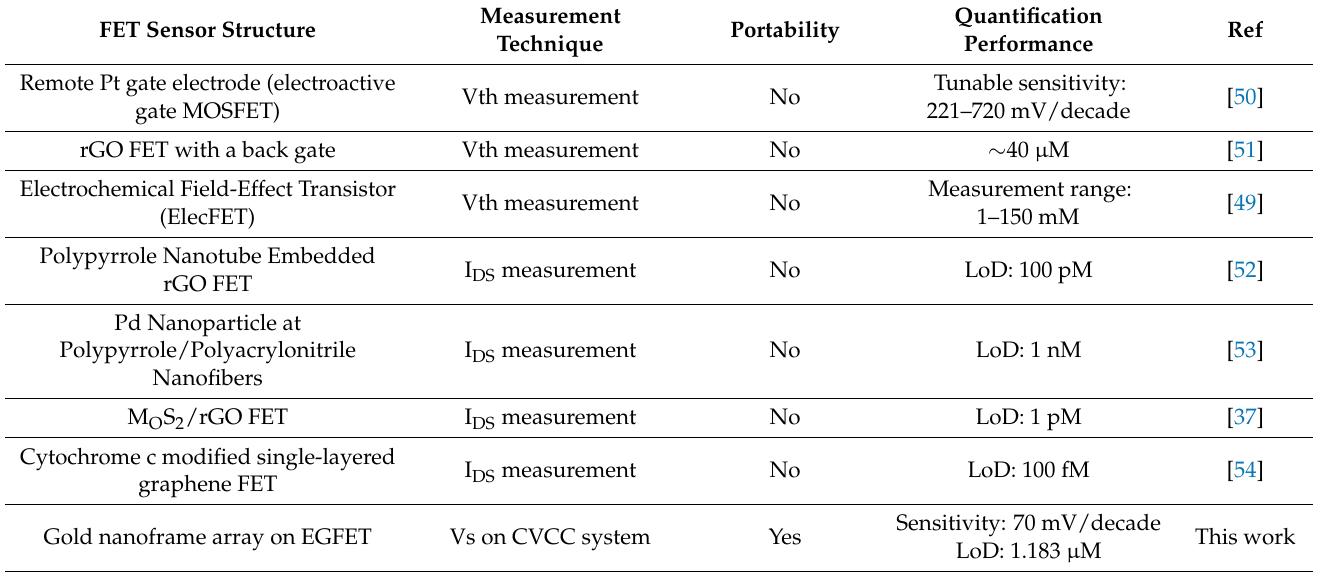
Table 1. Comparison of FET-based H 2 O 2 sensors in terms of sensing structure, measurement technique, portability, and performance.